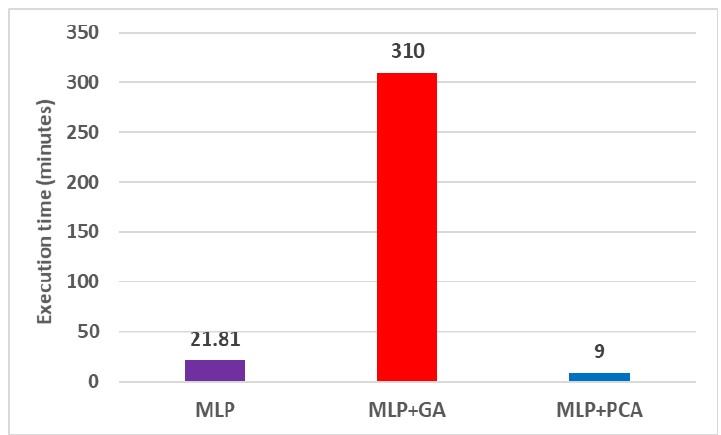
Figure 7. Comparative training time for MLP (21.81 min), MLP + GA (310 min) and MLP + PCA (9 min).